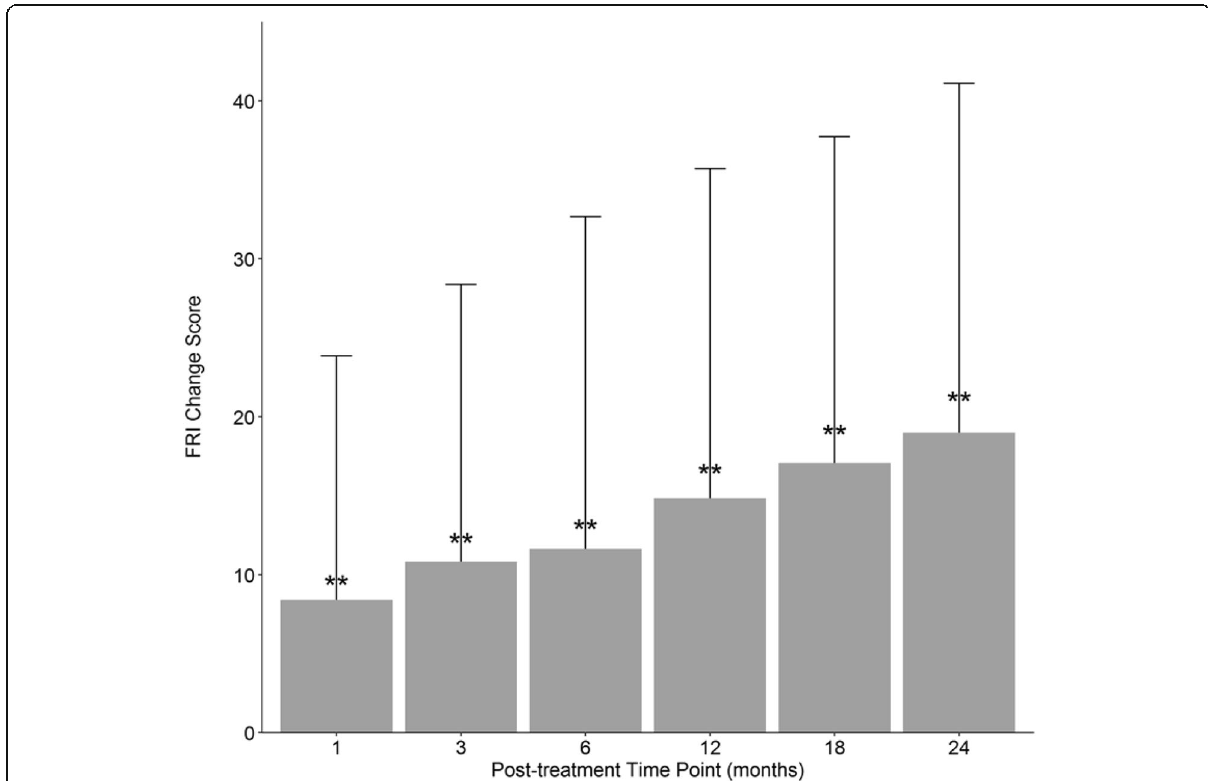
Fig. 5 FRI average change scores. Functional rating index (FRI) averaged change in scores from baseline at each post-treatment time point with standard deviation. The number of patients reporting at each time point: 1-month ( N = 111); 3-month ( N = 144), 6-month ( N = 146), 12-month ( N = 136), 18-month ( N = 114), 24-month ( N = 100). ** p <